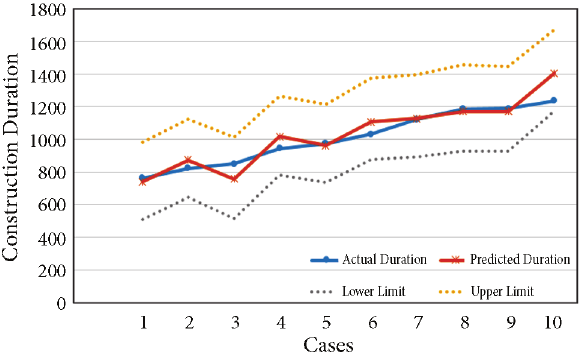
Figure 7. Actual construction duration vs. predicted construction